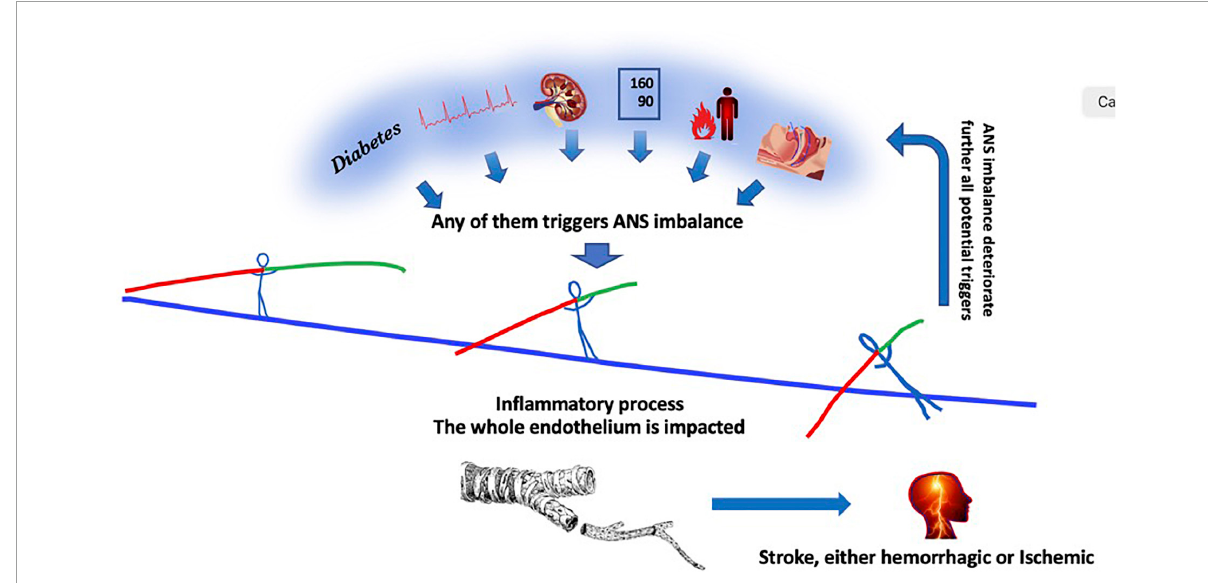
FIGURE2 From left to right, diabetes, atrial fibrillation, chronic kidney disease, hypertension, inflammation, sleep apnea disorders, any of them contribute independantly to a global decrease in ANS activity with creates a predominance in the sympathetic activity of the remaining ANS activity. The autonomic nervous system activity imbalance determines in turn a global excess in circulating inflammatory products which in turn impacts the whole 300 square meter endothelium monolayer tissue, ending finally in a stroke. The ANS imbalance crushes further endothelium function which in turn increases multi-organ damages, aggravating the deleterious